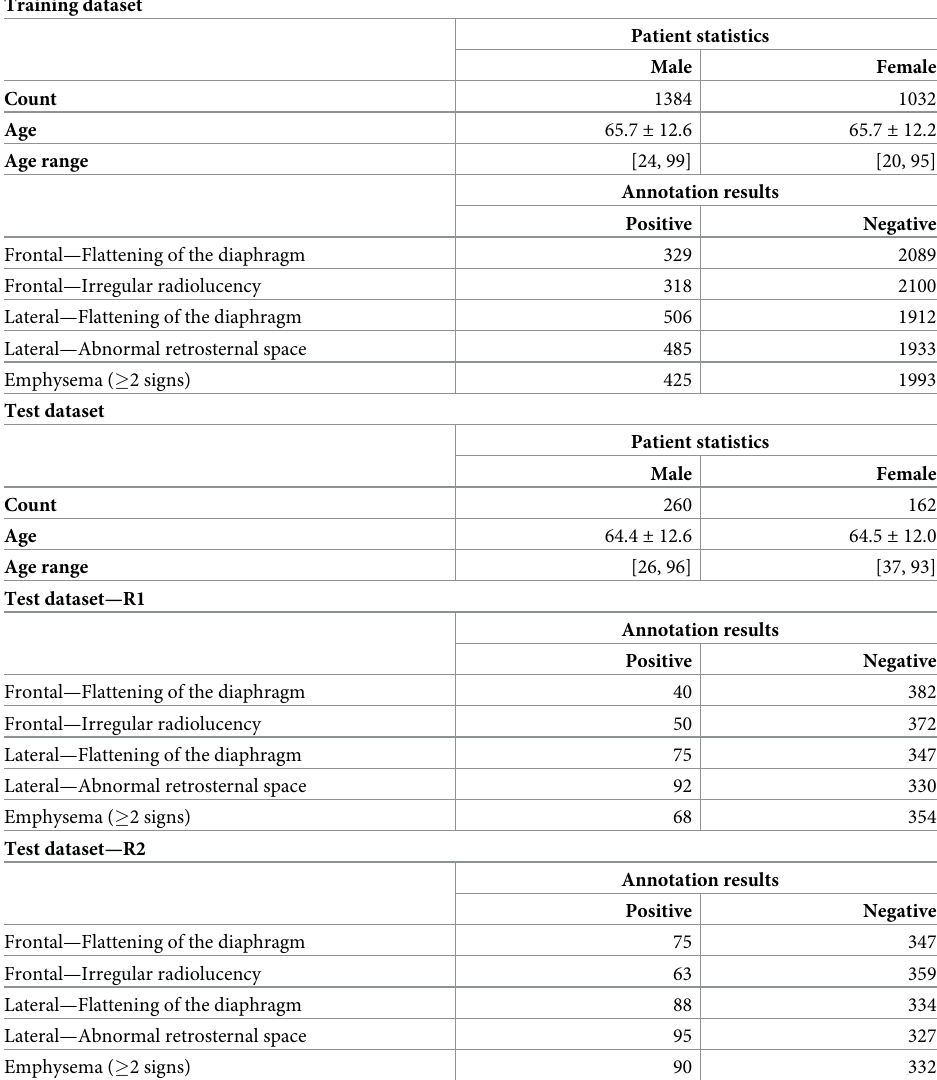
Table 3. Annotation results for the training and test